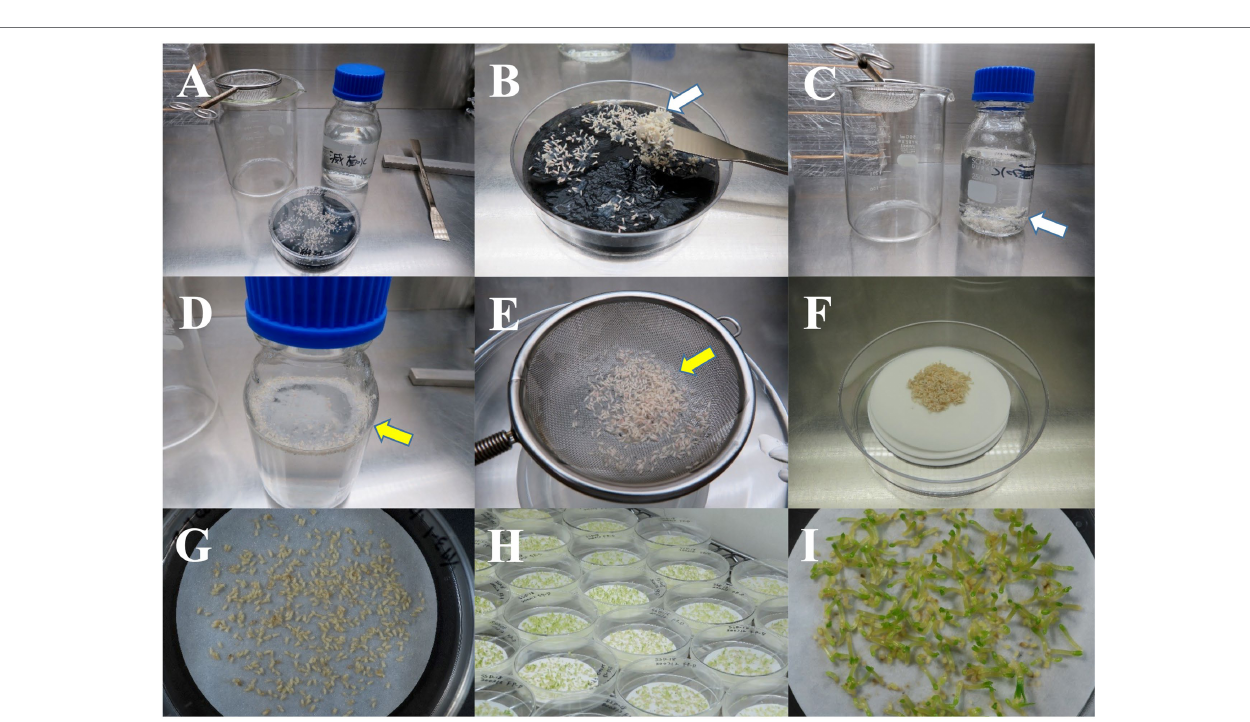
FIGURE 3 | Collection of pollen-free sugi ( C. japonica ) somatic embryos from the maturation medium. (A) Materials used for the collection of matured somatic embryos. (B) Clusters of somatic embryos and embryogenic cells (ECs; white arrow) collected using a spatula, then transferred into a flask with sterile distilled water (C) . (D) Embryos (yellow arrow) separated from the adhering proliferated ECs after vigorous shaking of the flask and then collected on a tea strainer (E) . (F) Collected embryos transferred into filter papers inside an empty plate. (G) Embryos placed into filter paper, then incubated inside empty plates for about 2 weeks before transfer to the germination/conversion medium (H,I) . Diameter of filter paper: 70